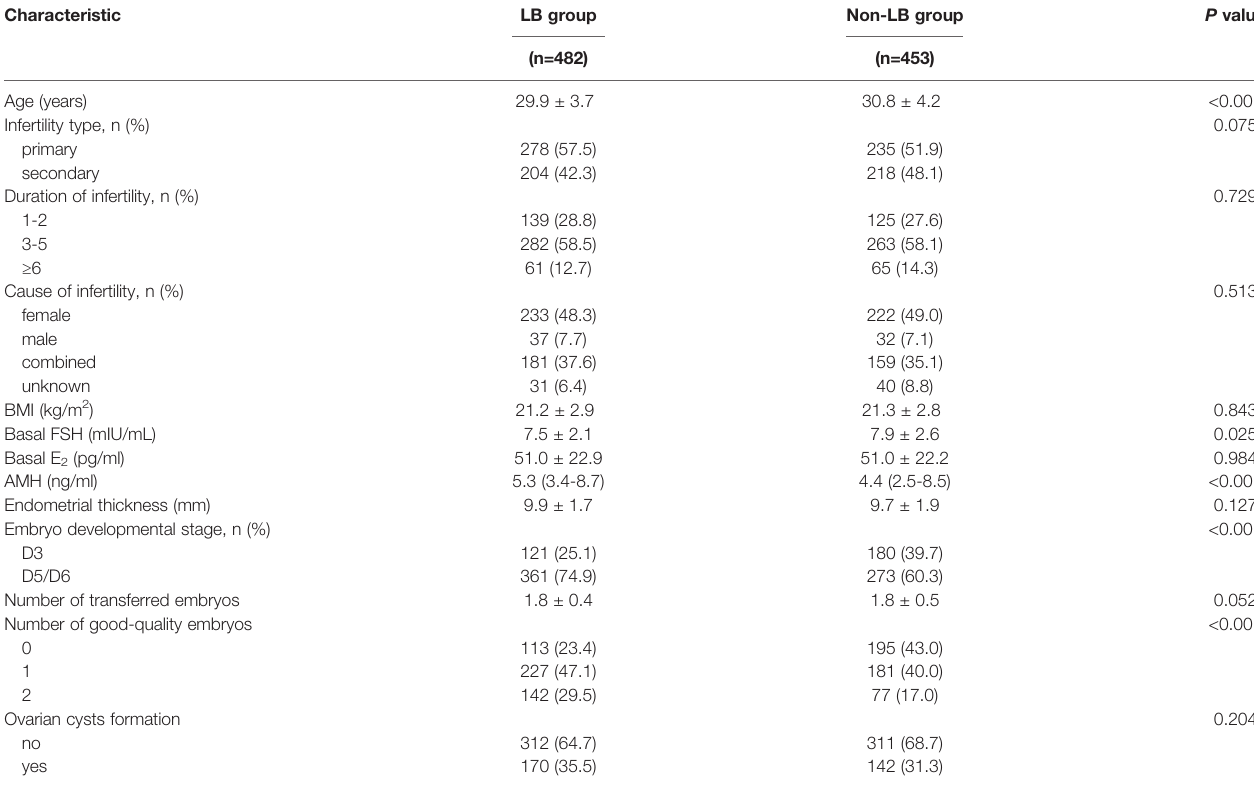
TABLE 4 | Characteristics between cycles reaching live births or failing to have live births in the overall population after propensity score matching.